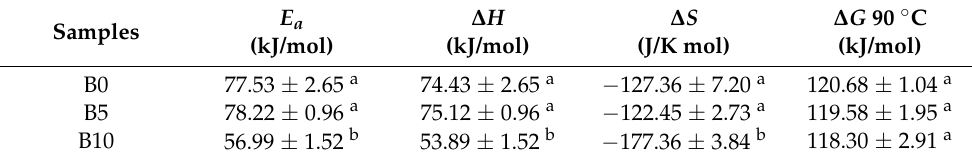
Table 3. Energy of activation ( E a ), enthalpy of activation ( ∆ H ), entropy of activation ( ∆ S ), and determination of Gibbs free energy at 90 ◦ C ( ∆ G 90 ◦ C) of control and fortified samples (B0, B5, and